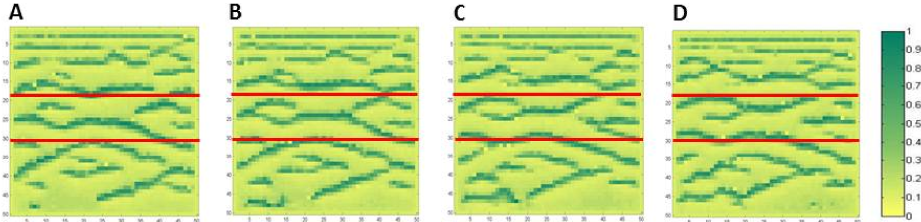
Fig. 16. Pattern migration. The evolution of a pattern is tracked through iteration steps (use red lines as reference): (A) 45; (B) 50; (C) 55; (D) 60.